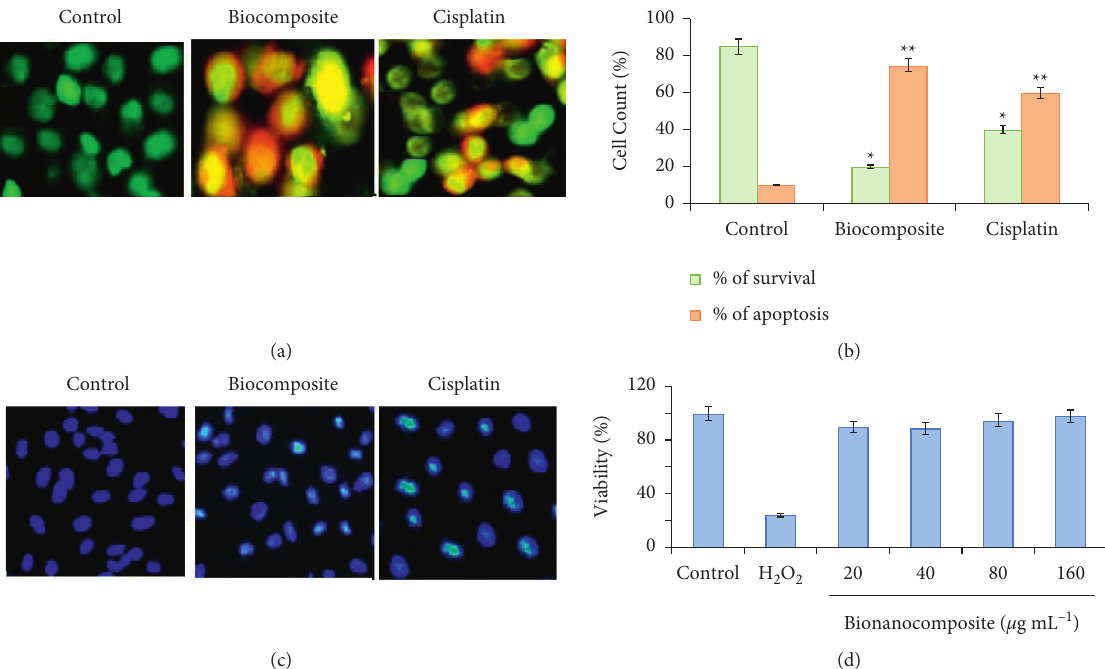
Figure 12: Apoptotic potential of the polymeric bionanocomposite at its IC 50 in A549 cells as illustrated by (a) AO/EtBr double staining, (b) quantification of apoptotic cells, (c) DAPI staining, and (d) safety assessment of the polymeric bionanocomposite (20–100 μ g mL − 1 ) on PBMC in comparison with 100 μ M H 2 O 2 after 24 h. Results are expressed as mean ± SD of triplicates, and the values are considered significant at ∗ ’ ∗∗ p < 0 . 05 treated vs.